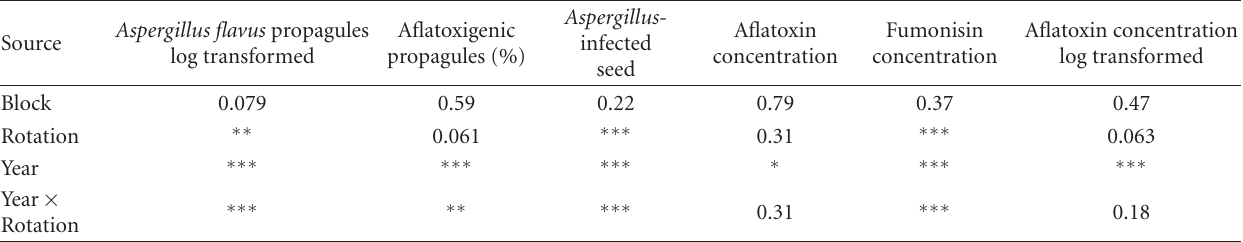
Table 2: Analysis of variance and probability values of seed quality parameters as a ff ected by block, rotation, year, and their interactions 1 .